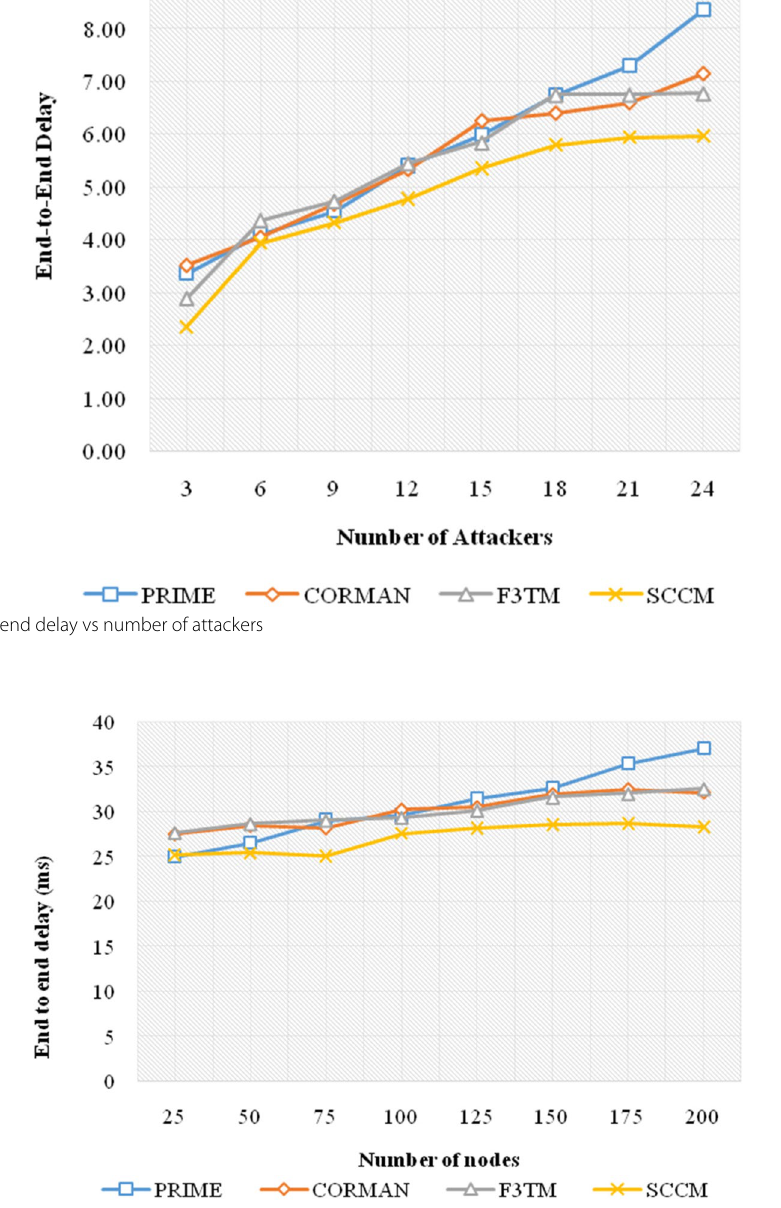
Fig. 11 Average end-to-end delay vs number of